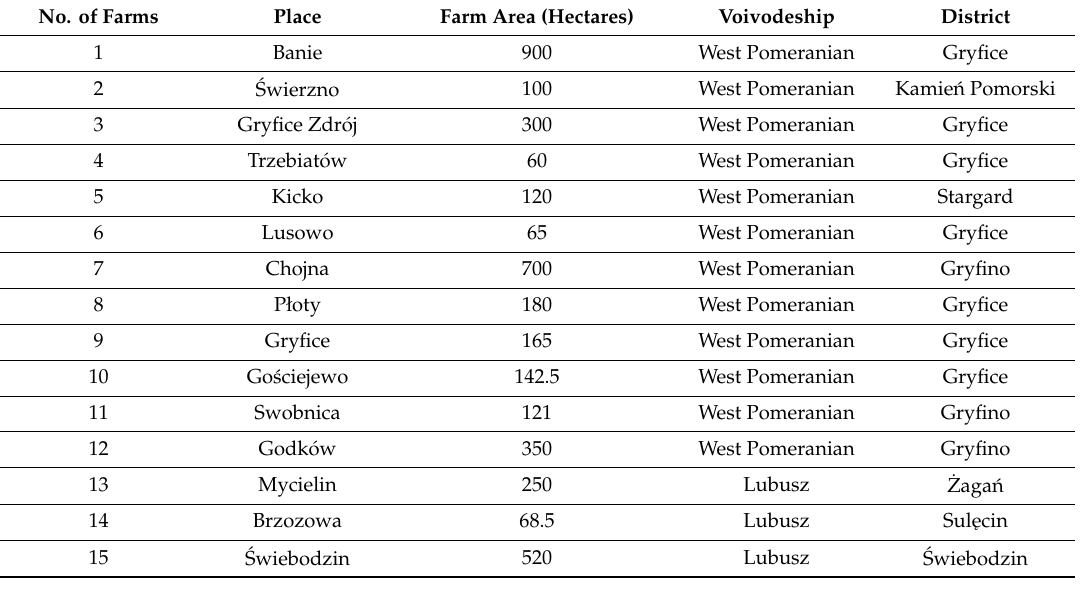
Table 1. Location and area of study farms.